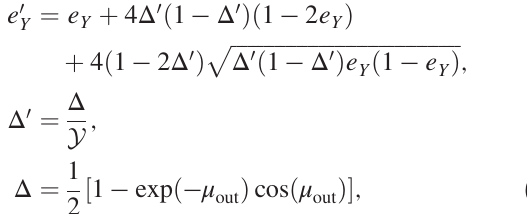
FIG. 3. Asymptotic key rate R versus distance for the single- photon efficient BB84 protocol under a THA. The rate is plotted for different values of the output mean photon number μ parameters in the simulation are as follows: fiber loss coefficient 0 . 2 dB = km, total detection efficiency 12.5%, optical error rate 1%, dark count probability per gate 10 − 5 , and error correction inefficiency 20% above the Shannon